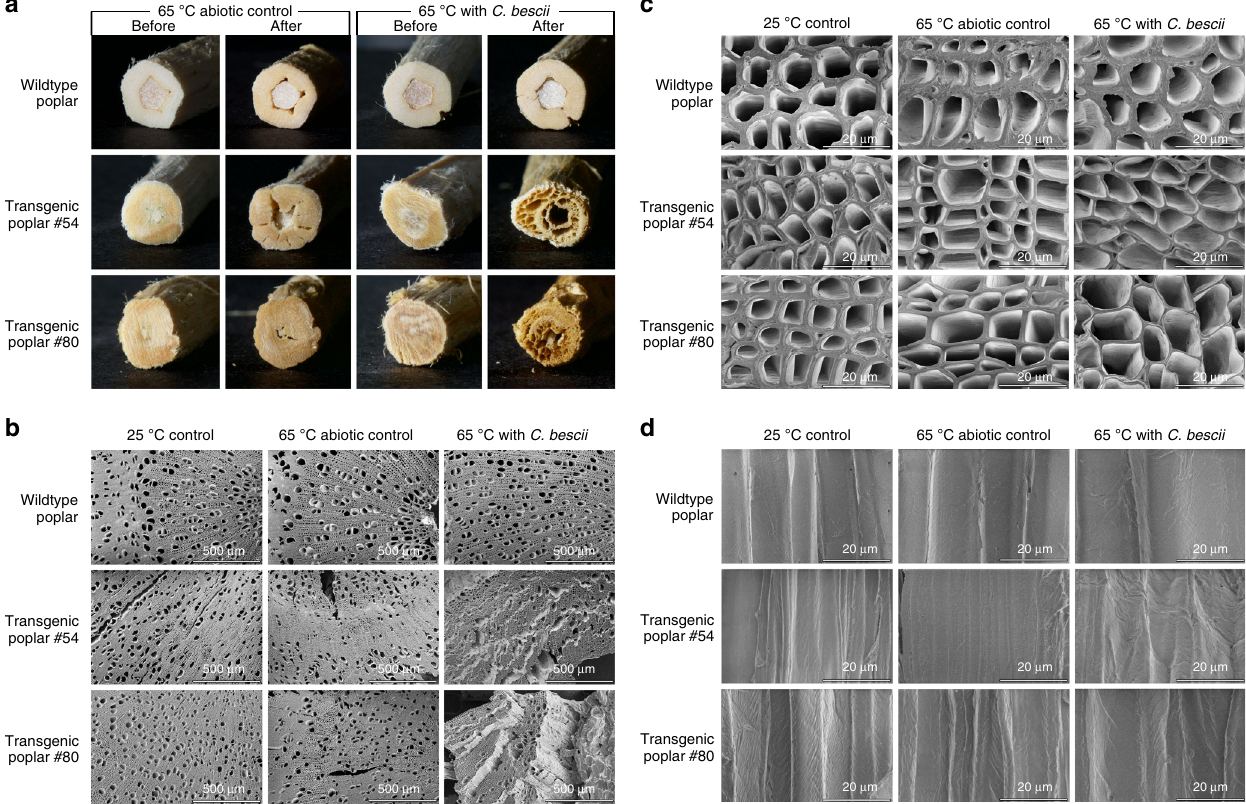
Fig. 2 Images of poplar stems with and without solubilization by C. bescii . Six-month-old stem segments were incubated for 7 days at 25 °C (25 °C control), at 65 °C without C. bescii (abiotic control), or at 65 °C with C. bescii . a End view of stems before and after treatment indicating the level of degradation. b Low-magni fi cation and c high-magni fi cation scanning electron microscopic images of stem cross-sections showing splits, fragmentations, and the effects of lignin modi fi cation and C. bescii solubilization on the xylem cell wall fi bers. d Comparison of longitudinal xylem fi ber cell surfaces for different